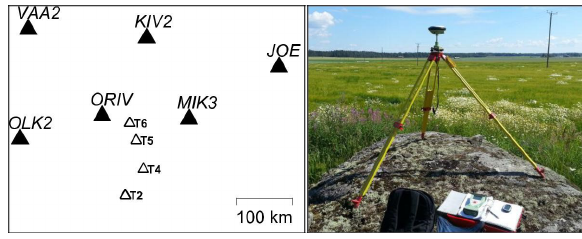
Figure 4: On the left there are the reference stations and test points T1 and T4-T6 which were used in the extrapolation test. During the measurements the southernmost FinnRef stations were deacti- vated. On the right is an example of the test setup at the test point. The RTK rover is set up on the benchmark using a tripod and tri- 122.3 (VIR2) brach with an optical plummet. For geographical location compare with Fig.